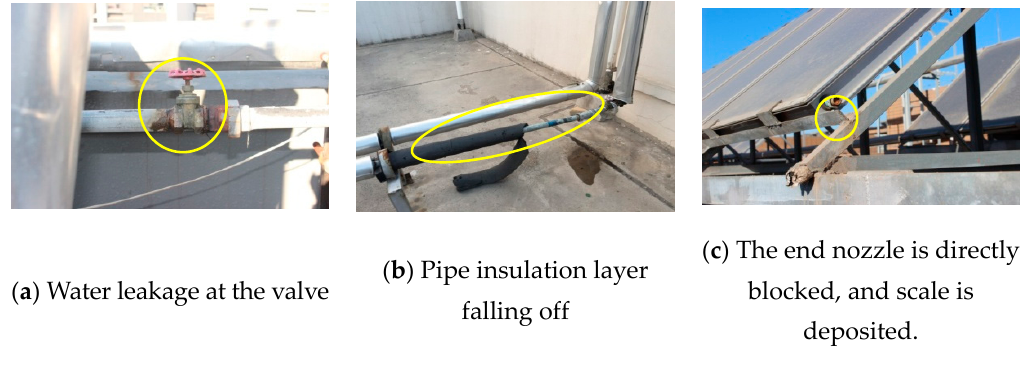
Figure 4. Common problems with piping systems.